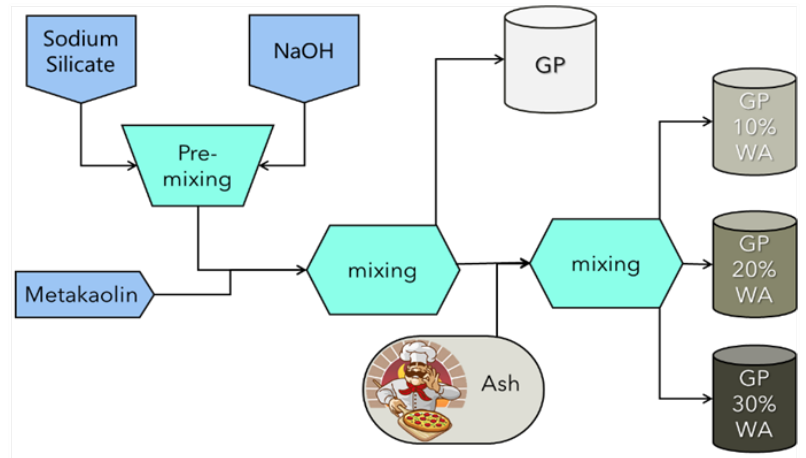
Figure 1. Flowchart showing the synthesis process of all the samples.